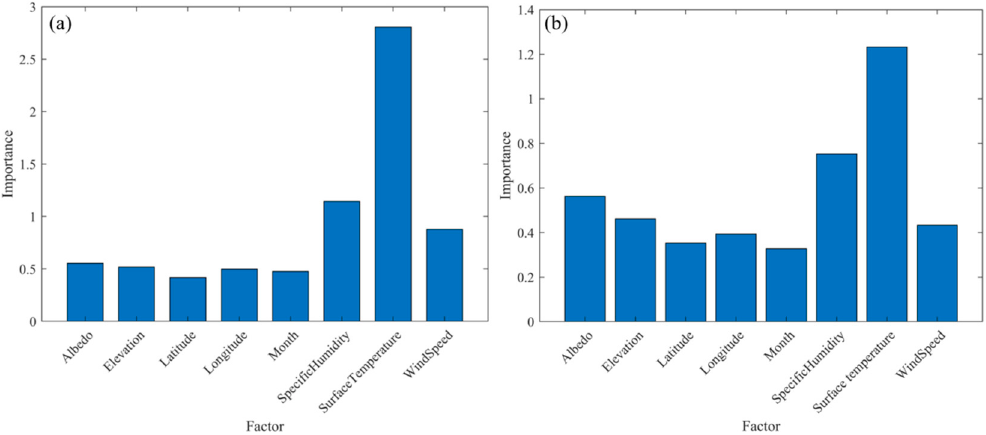
Figure 3. Daily data ( a ) and monthly data ( b ) rankings for eight factors.